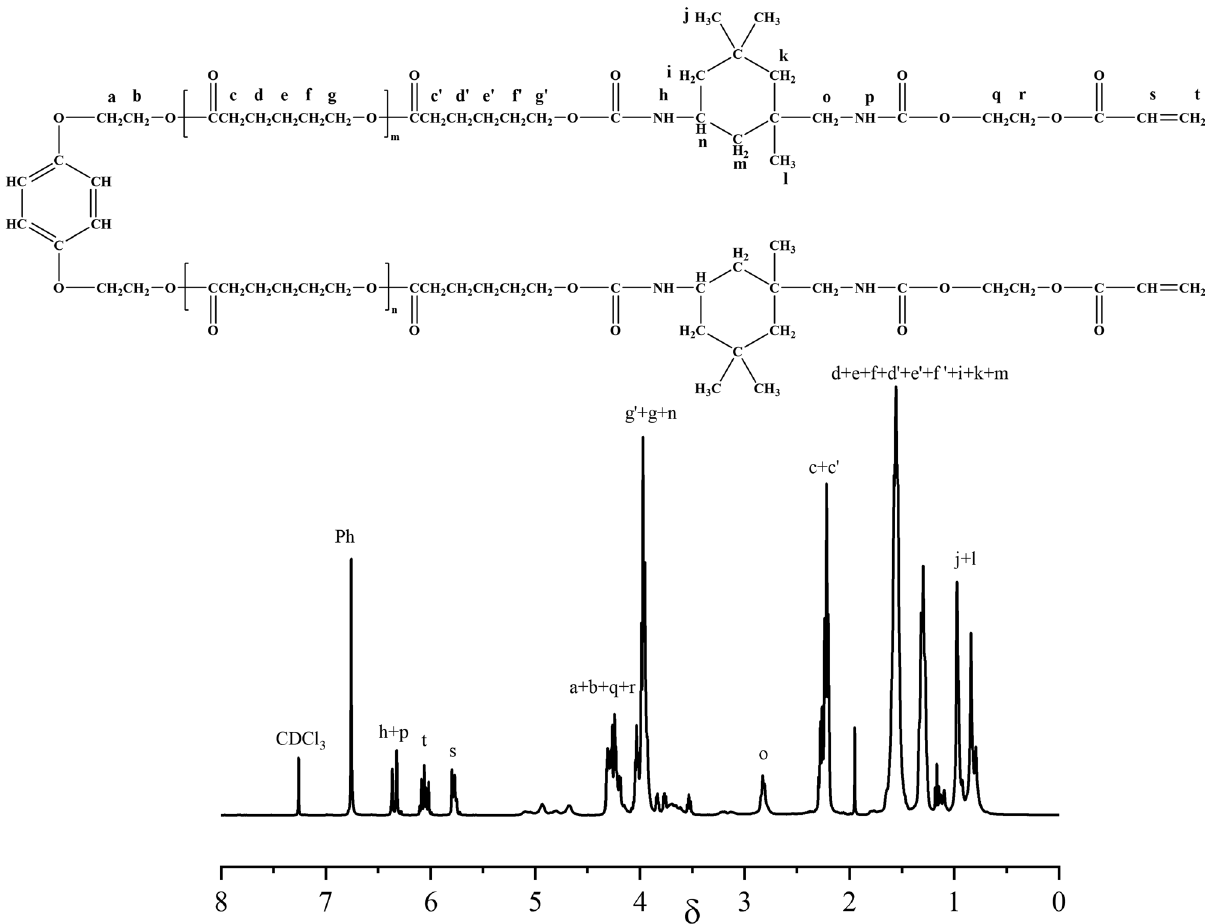
Figure 9: 1 H - NMR spectrum of